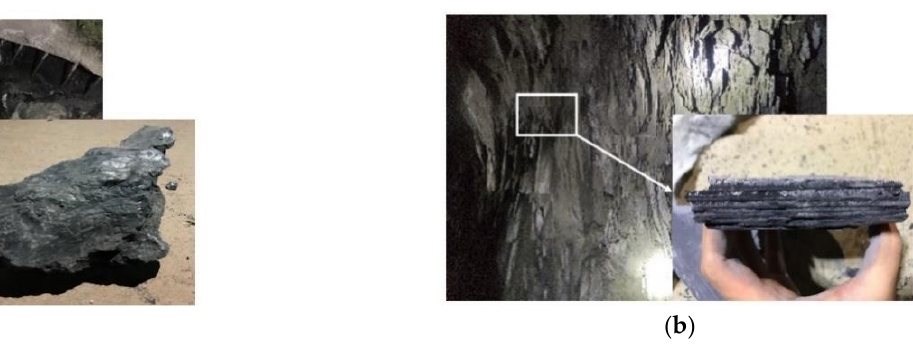
Table 1. Numbers of different location s’ carbonaceous slate samples.